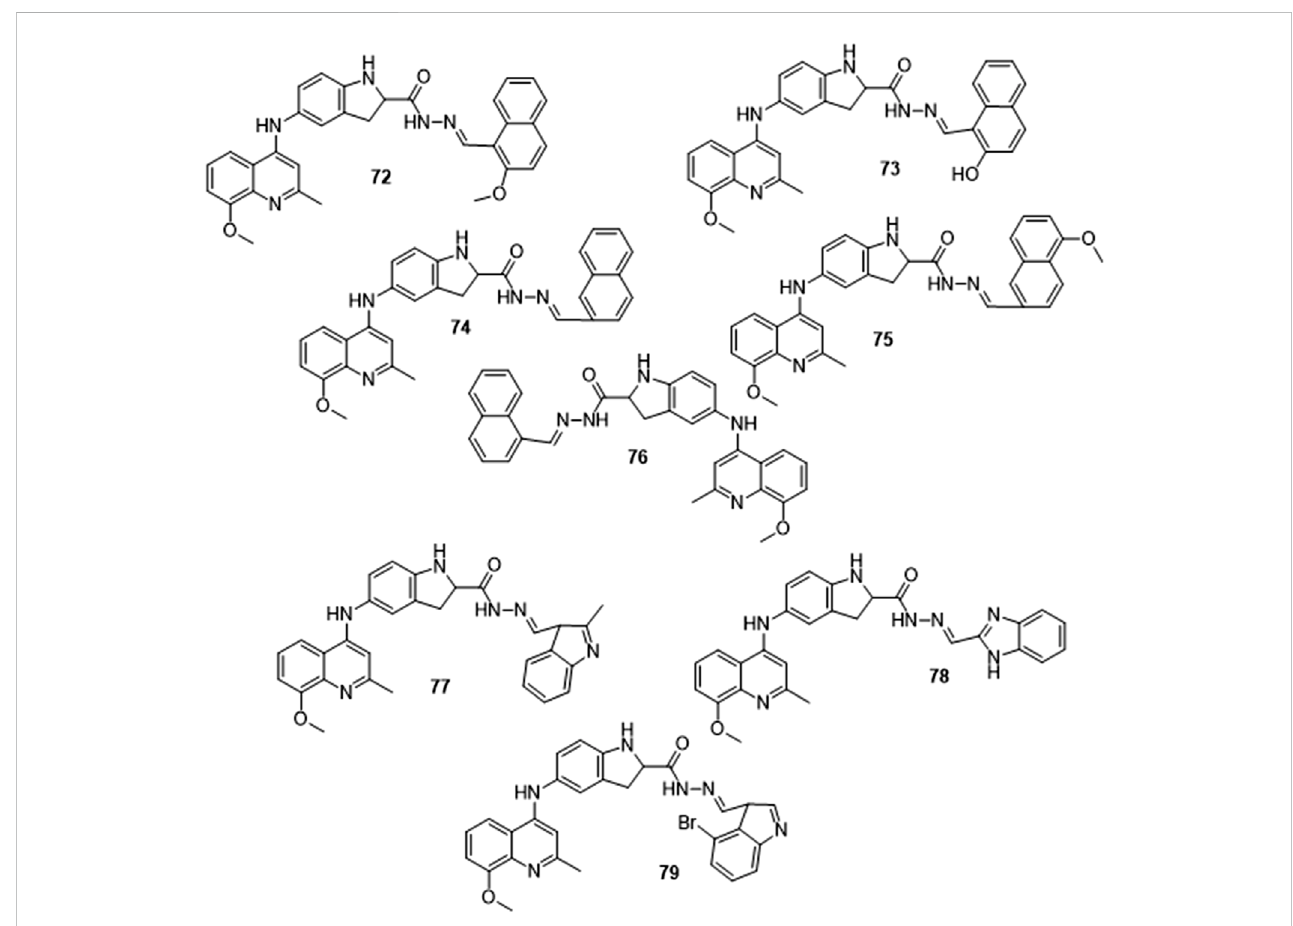
FIGURE 16 Quinoline-Indole-Schiff base derivative.